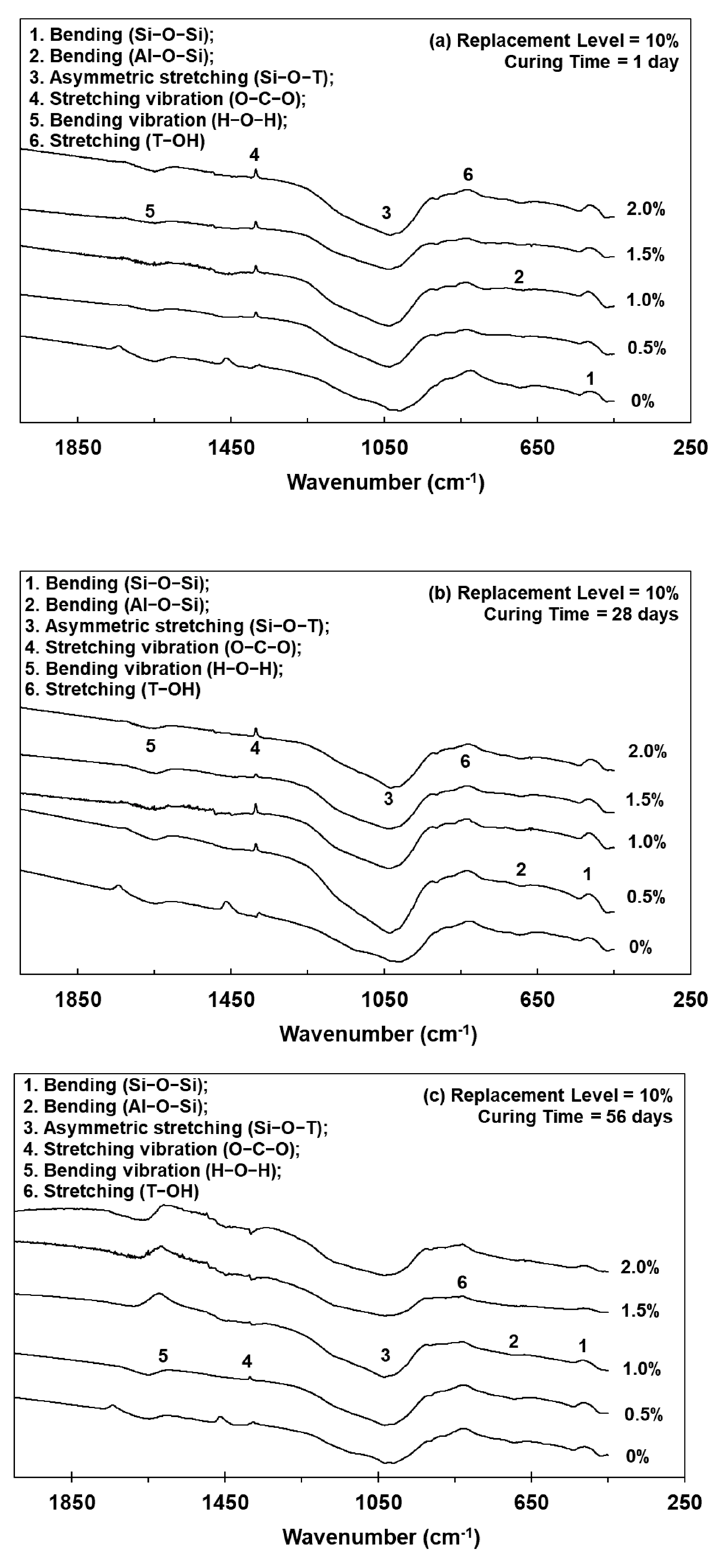
Figure 4. FTIR spectrums of lightweight FGPs. (Replacement level = 10%). ( a ) 1day; ( b ) 28 days and ( c ) 56 days